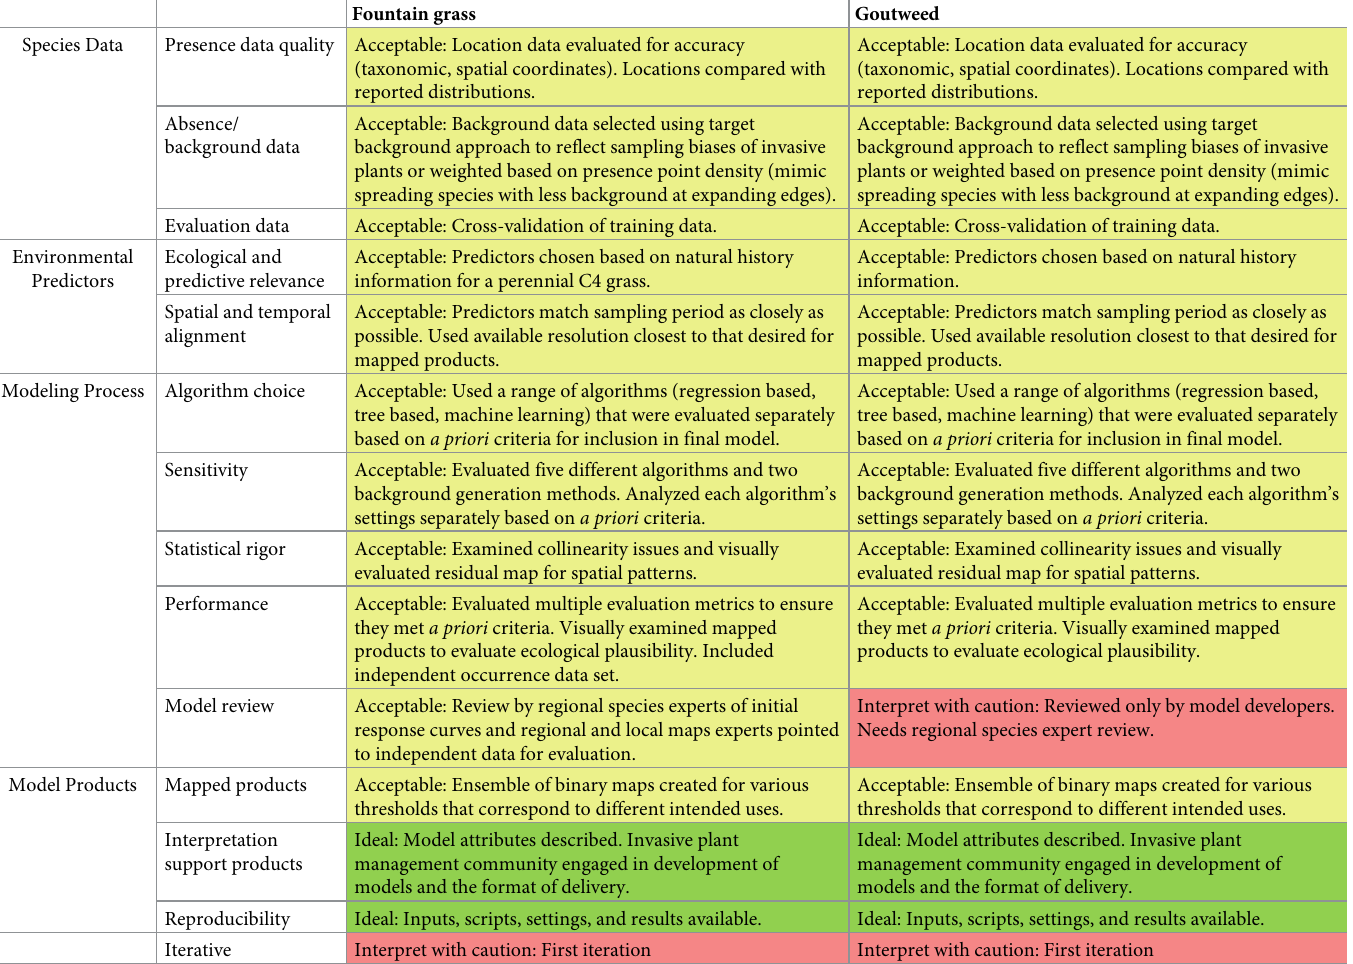
Table 4. Model assessment rubric from Sofaer et al. [12] for fountain grass and goutweed models. Fountain grass Goutweed Species